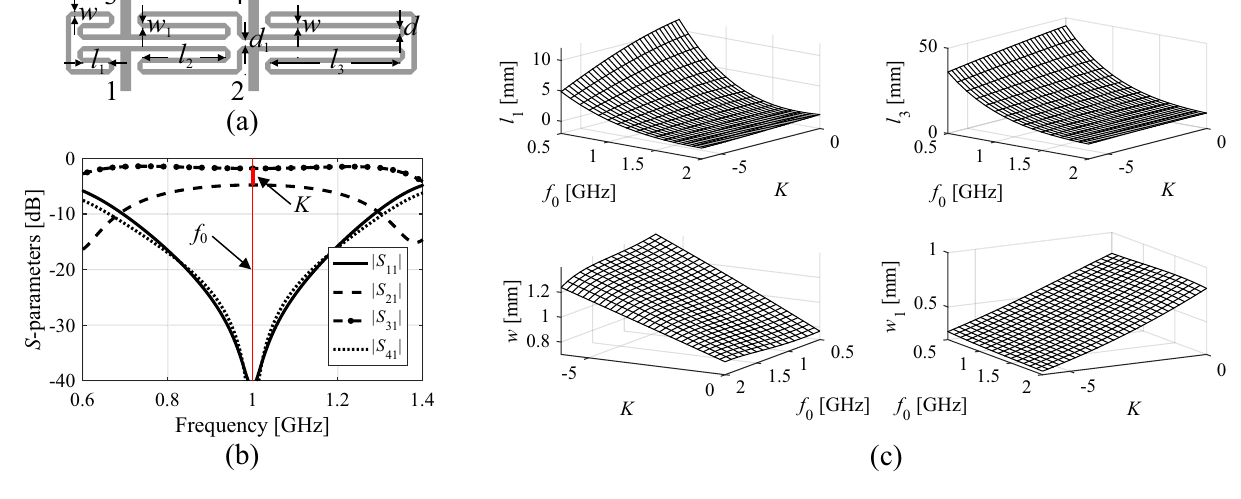
Figure 2. Miniaturized rat-race coupler 53 : ( a ) circuit geometry, ( b ) typical S -parameter response, ( c ) two- dimensional surfaces corresponding to (approximately) optimum designs obtained for various target operating frequencies and power split ratios, here, shown for the selected geometry parameters.